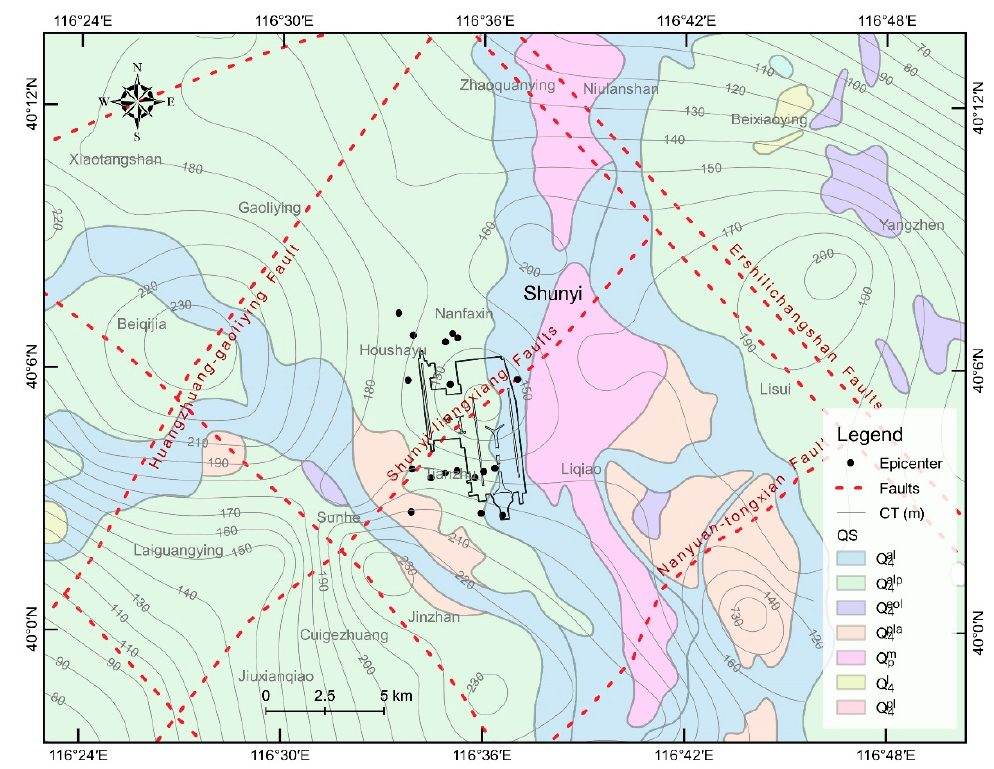
Figure 2. The distribution map of the quaternary sedimentary types and major faults around BCIA, Shunyi County. The red dash line represents the direction of the fault. The black points indicate the locations of minor earthquake epicenters recorded near the BCIA. The black outline indicates the airport boundary. The gray contour with digitals represents the thickness of the compressible layer. The Q al , Q alp , Q eol , Q pla , Q m p , Q l , and Q pl indicate the quaternary 4 4 4 4 4 4